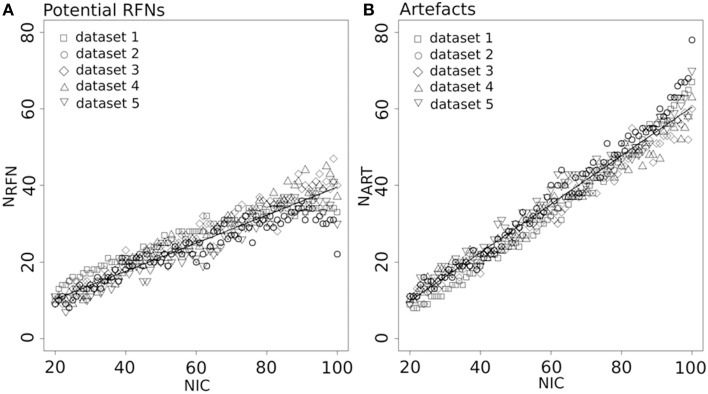
Number of RFNs (A) and artifact components (B) determined from automated classification as a function of NIC for the datasets 1–5. The lines indicate the least-square fittings of a linear function to the average data.